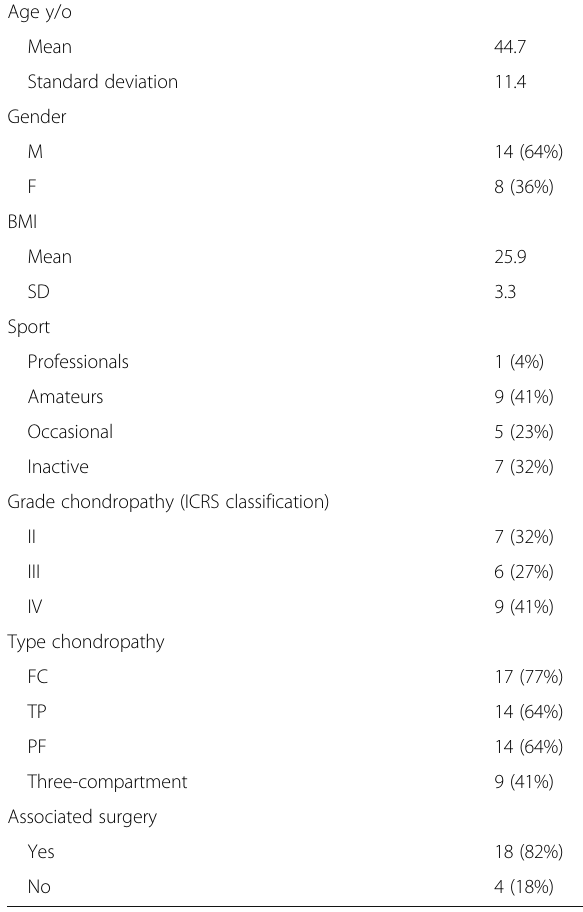
Table 2 Background data of the population ( n =